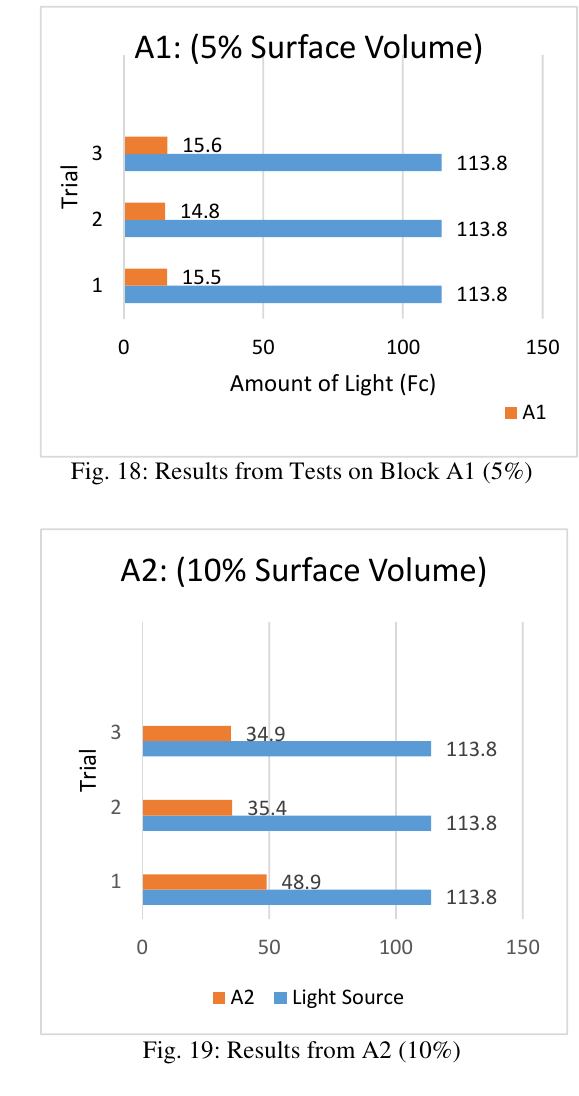
Fig. 19: Results from A2